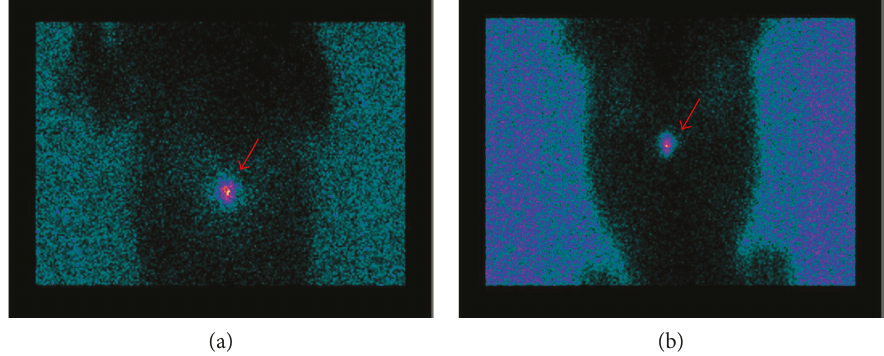
Figure 4: Scintigraphy of dogs injected with 99m Tc-labeled adipose tissue-derived mesenchymal stem cells. Representative scintigraphy images are shown for animal 4 and were obtained either 1 (a) or 24 hours (b) after cell injection. The arrows point to single radioactive spots (color). Body contours were revealed by using a germanium fl ood source. Cells are located in the thoracic spine at both 1 and 24 h after transplantation. Transplanted cells remained at the injection site for the fi rst 24 h after